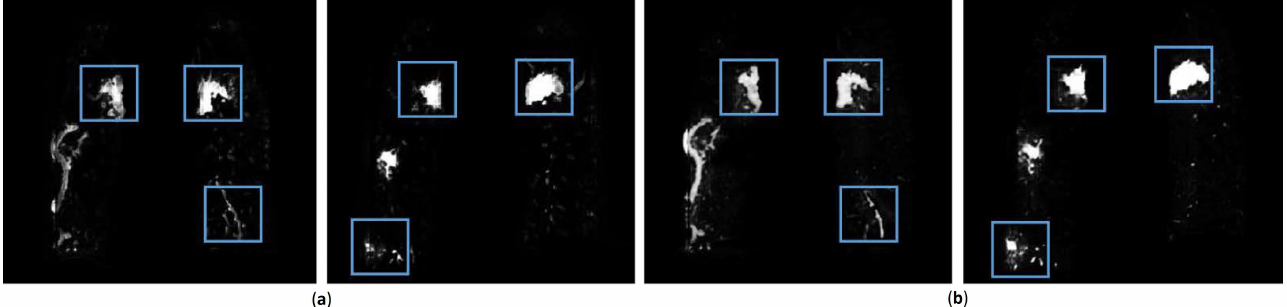
Figure 6. Two output maps from network. ( a ) is results trained by original data. ( b ) is results trained by enhanced data.